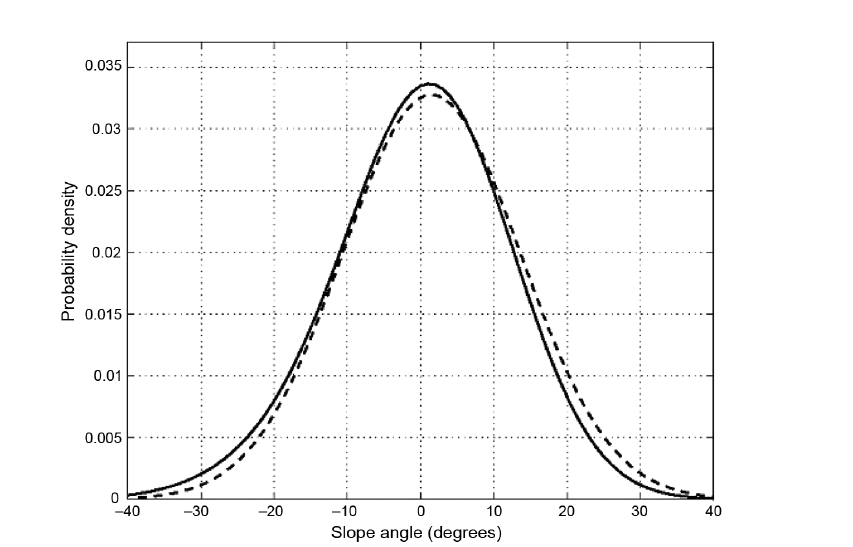
Fig. 3. Sea-surface slope probability density function (solid line) shown with the best-fit Gaussian distribution (dashed line). Downwind slopes are positive. Zero is at nadir, indicating a horizontal